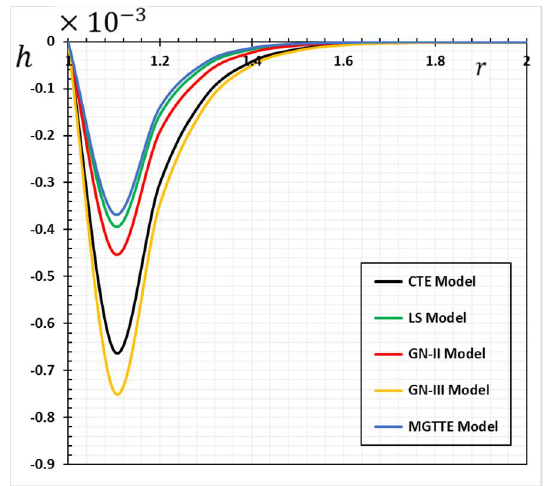
Figure 13. The induced magnetic field, ℎ , versus different thermoelastic models.